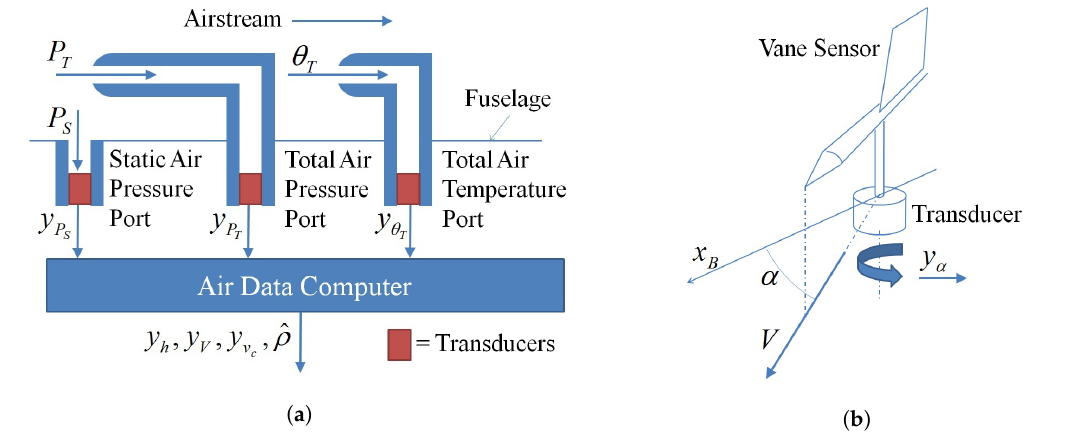
Figure 2. Air Data System: ( a ) Computing of the air data; ( b ) Angle of Attack Measurement Subsystem: the axis x B is a body fixed reference